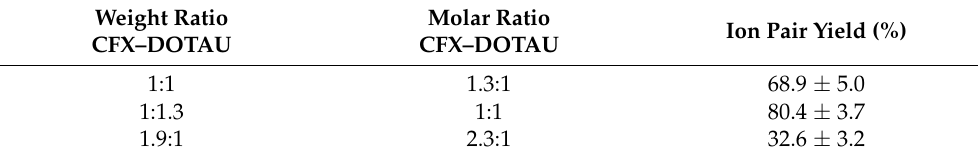
Table 1. Yield of ion pair formation at different ratios of CFX–DOTAU during formulation.